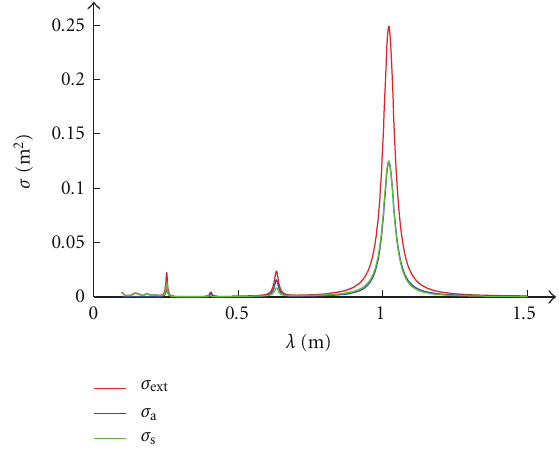
Figure 7: Extinction, absorption, and scattering cross sections of the spherical helix depicted in Figure 4 as function of wavelength, / f . λ = 2 π/k = c 0